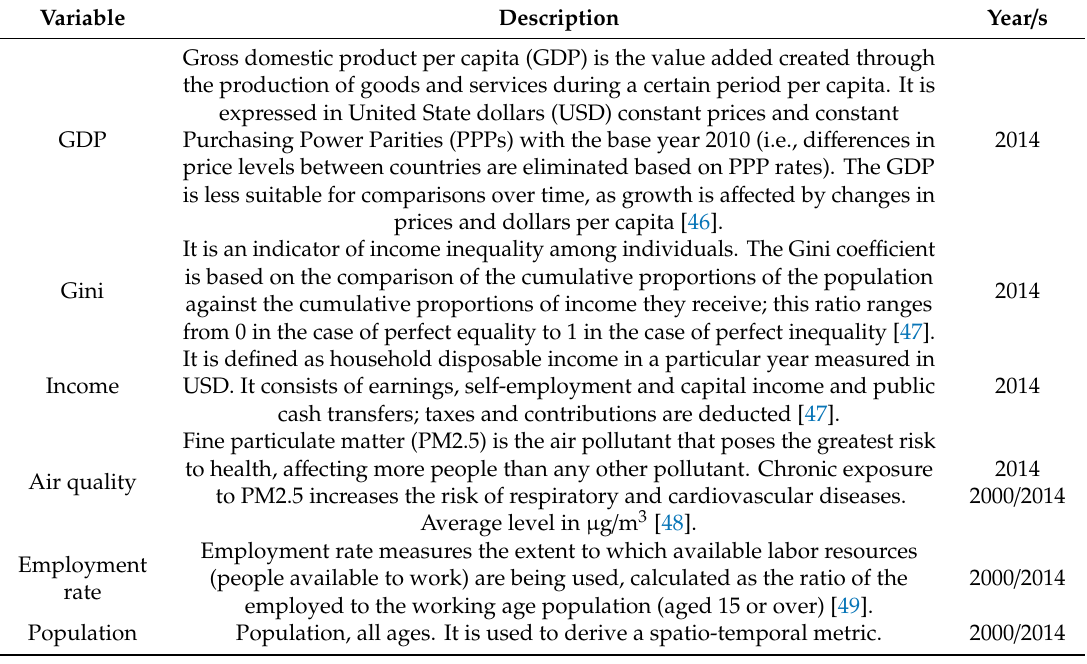
Table 1. Description of socio-economic and environmental variables modeled for 2014 or their change between 2000 and